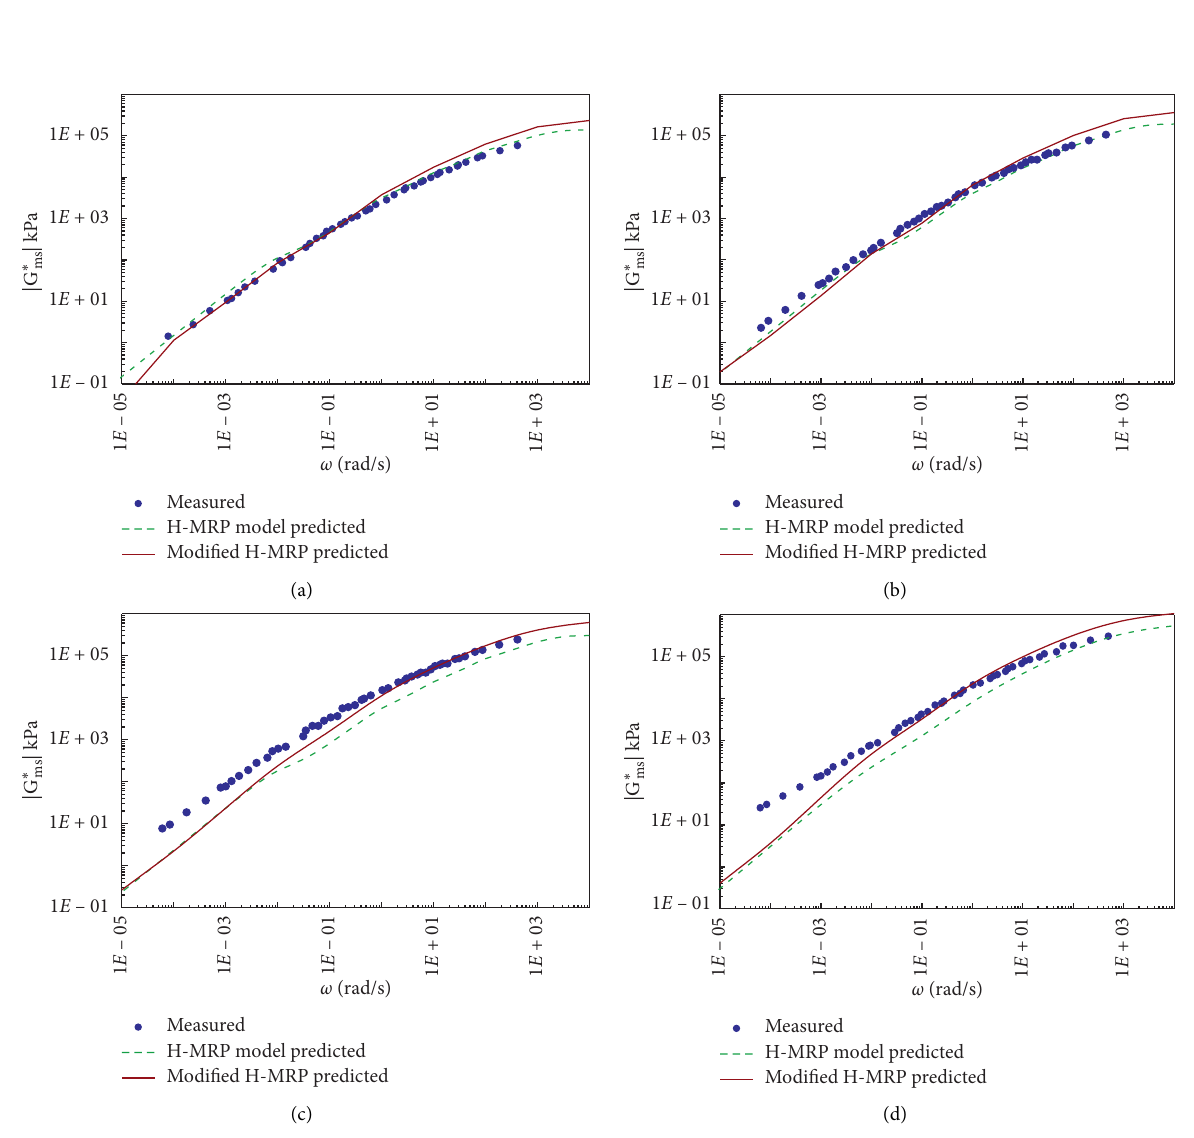
| values. (a) MS10. (b) MS20. (c) MS30. (d) ms